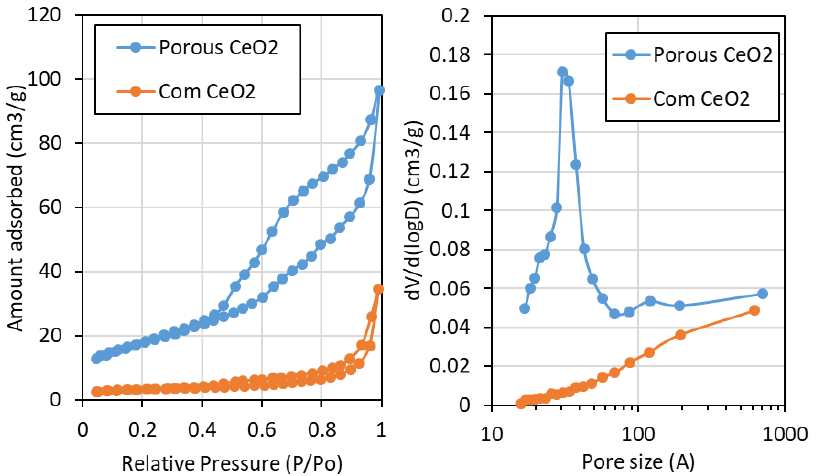
Figure 2. Left: The N 2 sorption isotherms of the prepared porous ceria compared with a commercial ceria sample. Right: the corresponding pore size